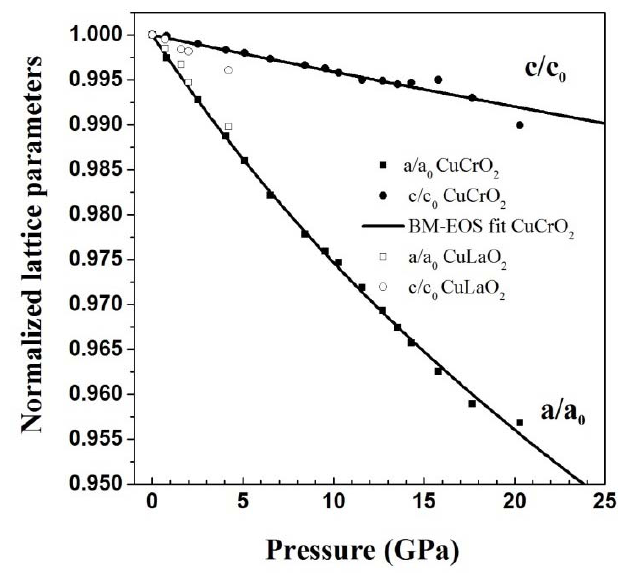
Figure 11. Normalized cell parameters of CuCrO 2 and CuLaO 2 . Both the samples show anisotropic compression. Symbol are explained in the figure.